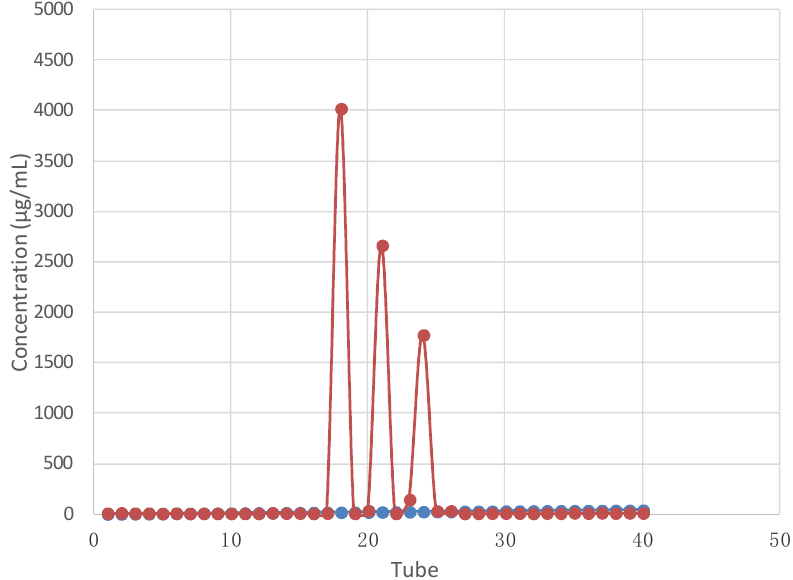
Figure 1. Elution curve of three polysaccharide fractions purification with HPGPC chromatograms.